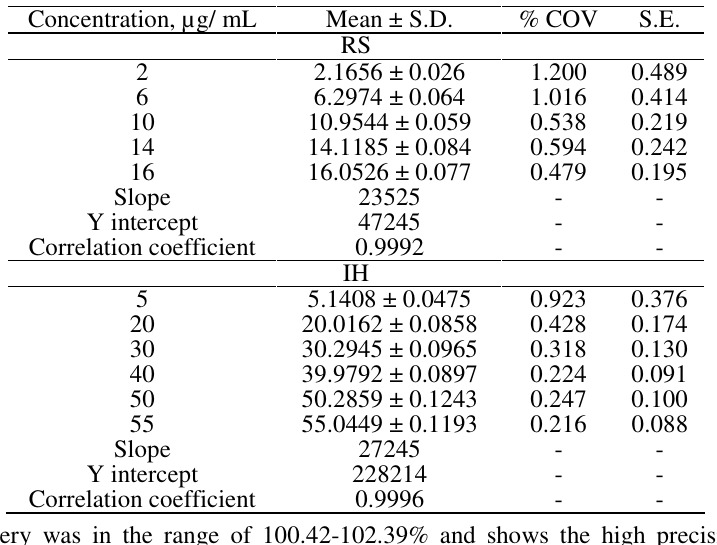
Table 3. Results from the study of linearity.